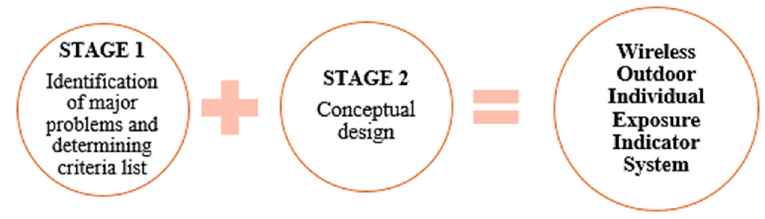
Figure 1. Summary of the design process.